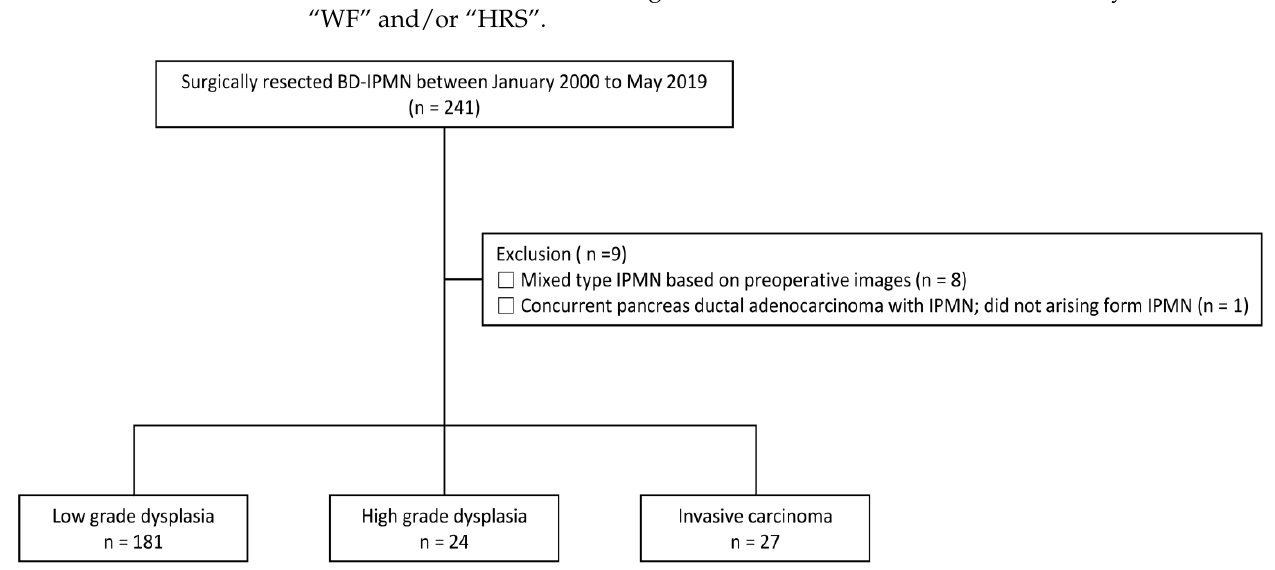
Figure 1. Flow diagram showing the selection for patients on branch-duct intraductal papillary mucinous neoplasm (BD-IPMN).